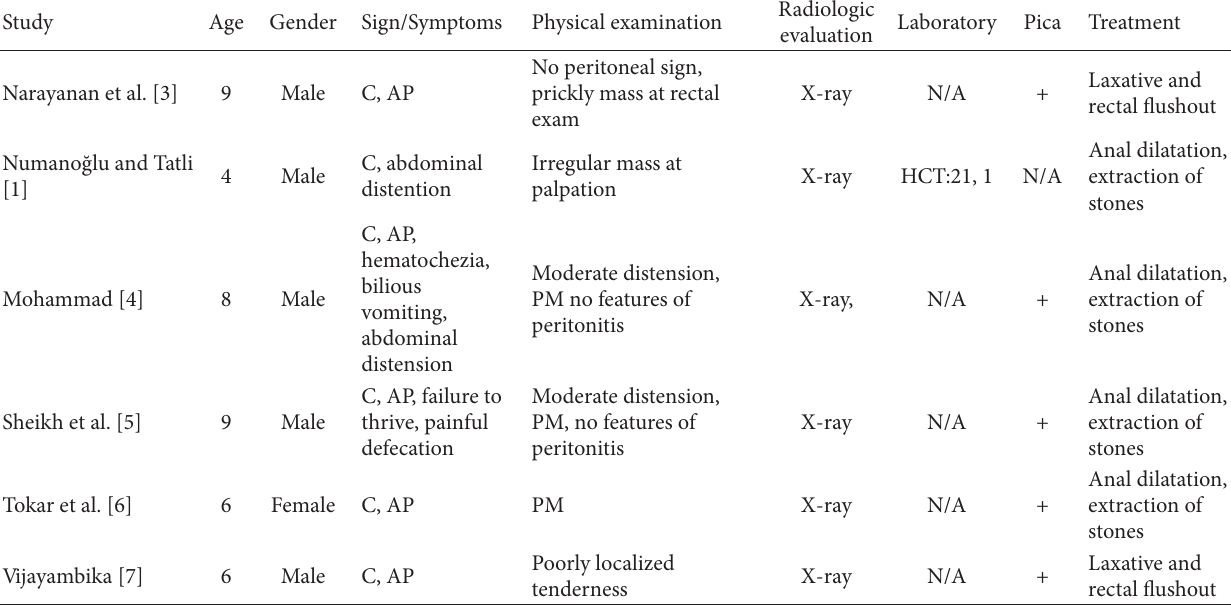
T 1: Colonic lithobezoar in children overview of